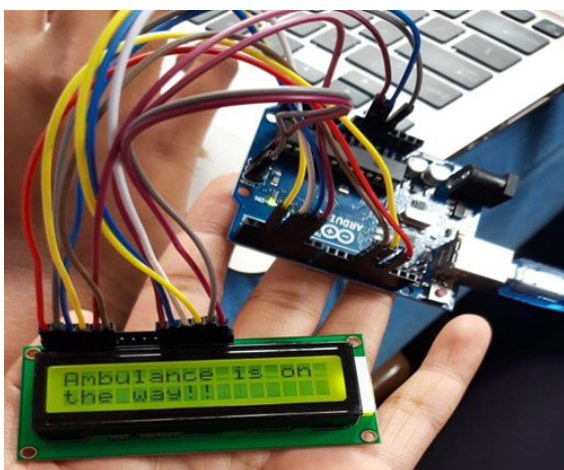
Fig. 9 . Message displayed on LCD screen Table 1. Read range testing of RFID reader